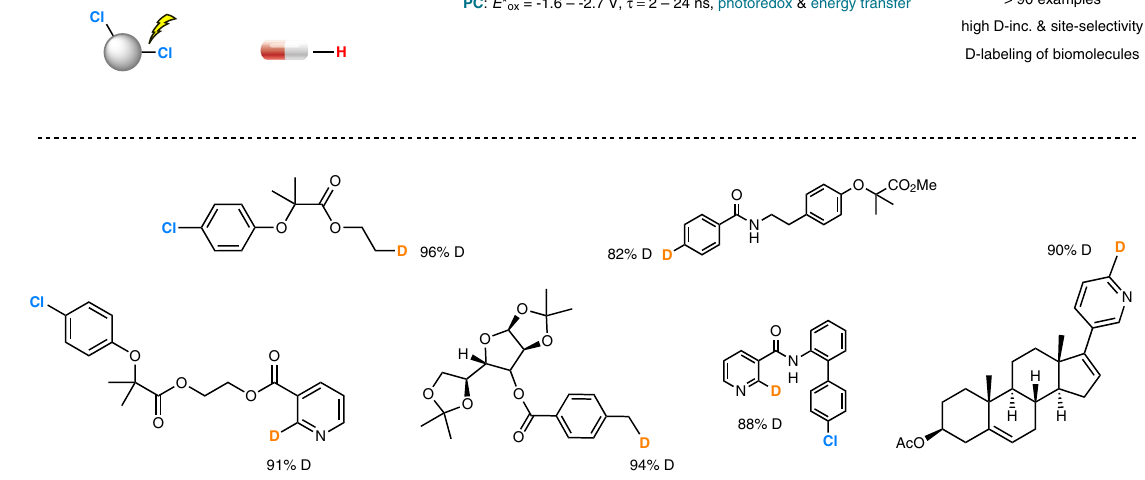
(cid:129) highly negative E red ( -1.8 – -3.0 V) of C-Cl bonds (cid:129) strong tendency to side reactions